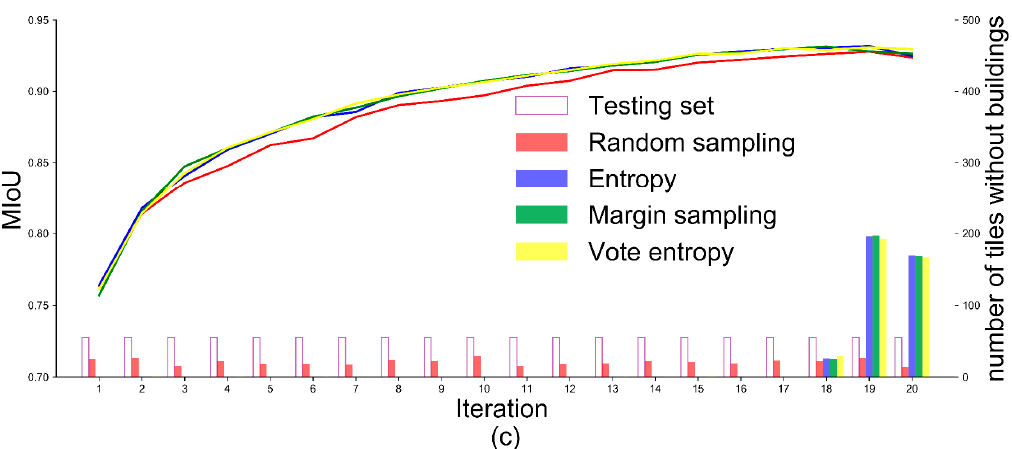
Figure 5. Comparison of AL strategies and random sampling based on WHU aerial building dataset. The X -axis represents the number of iterations in the experiments ( a – c ). The left Y -axis represents the mIoU value of DeeplabV3+ in each iteration. The right Y -axis represents the landscape metric value of selected tiles per iteration and all image tiles in the testing set. The active selection starts from the second iteration, and the image tiles with more buildings and the larger area of buildings are prioritized during the process of active data selection.